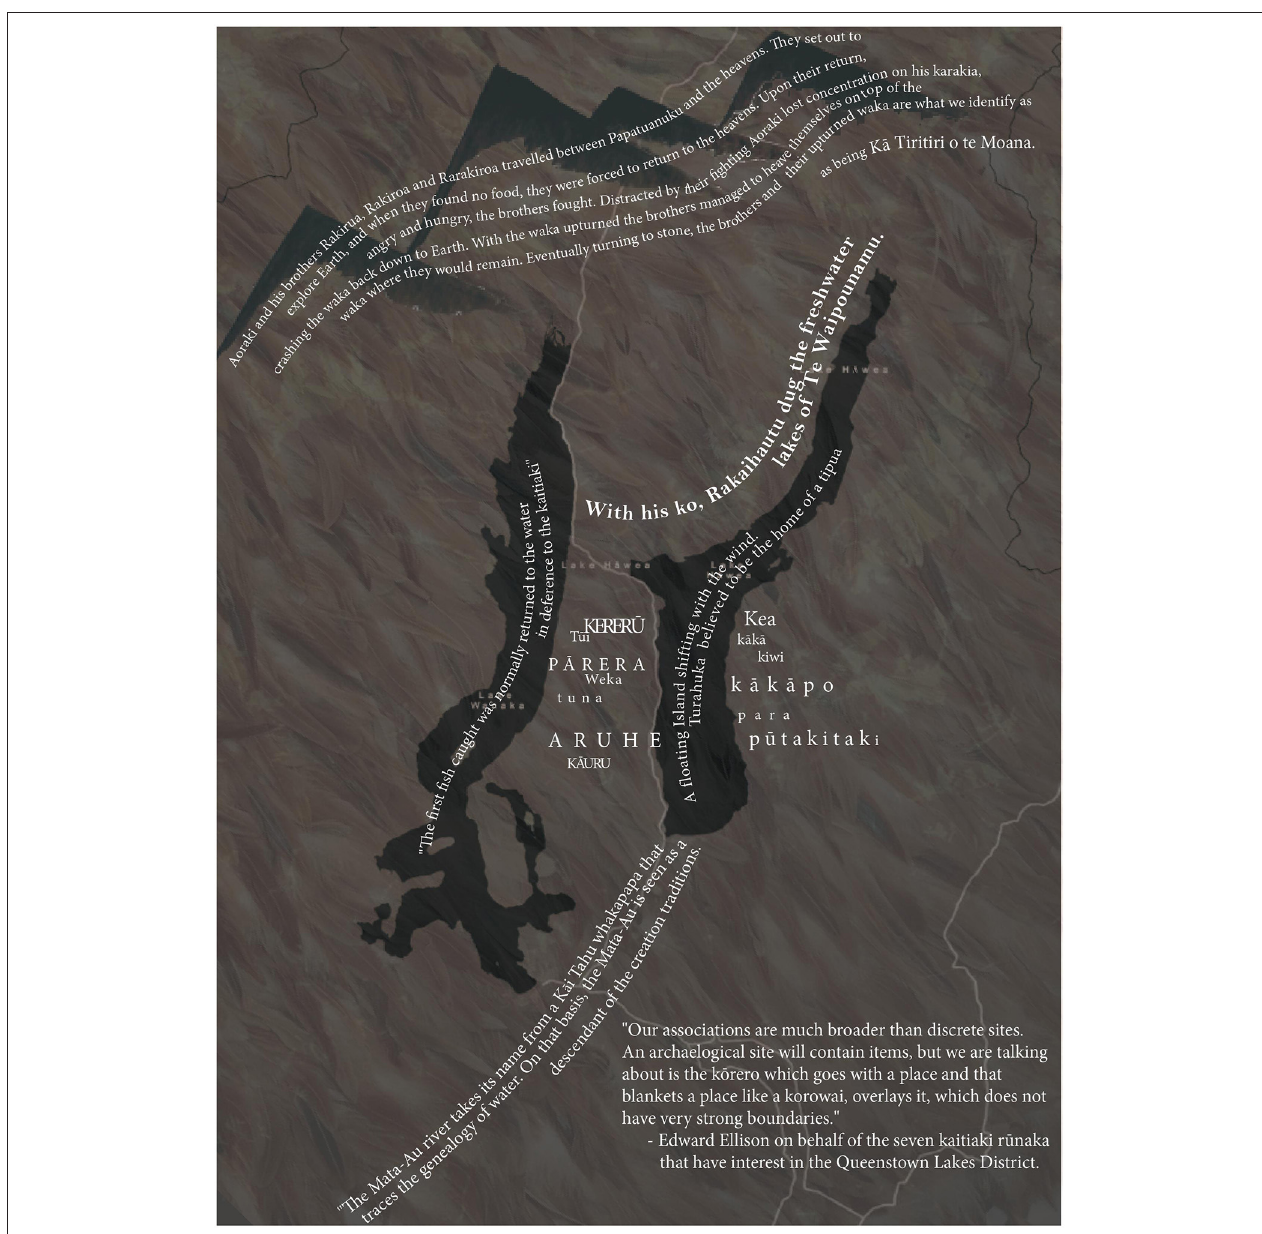
FIGURE 11 | A cultural map of the Mt. Grand